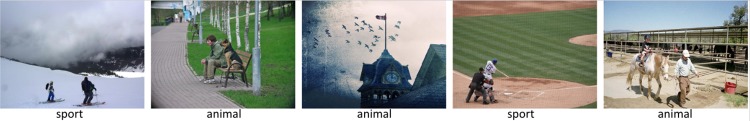
Qualitative evaluation between humans and computational models.Five images with the least recognition rate by human observers are displayed, respectively. The target categories are mainly sport and animal, with the smallest display size. In contrast to human performance, computational models are able to correctly recognize the respective categories in most of these images.